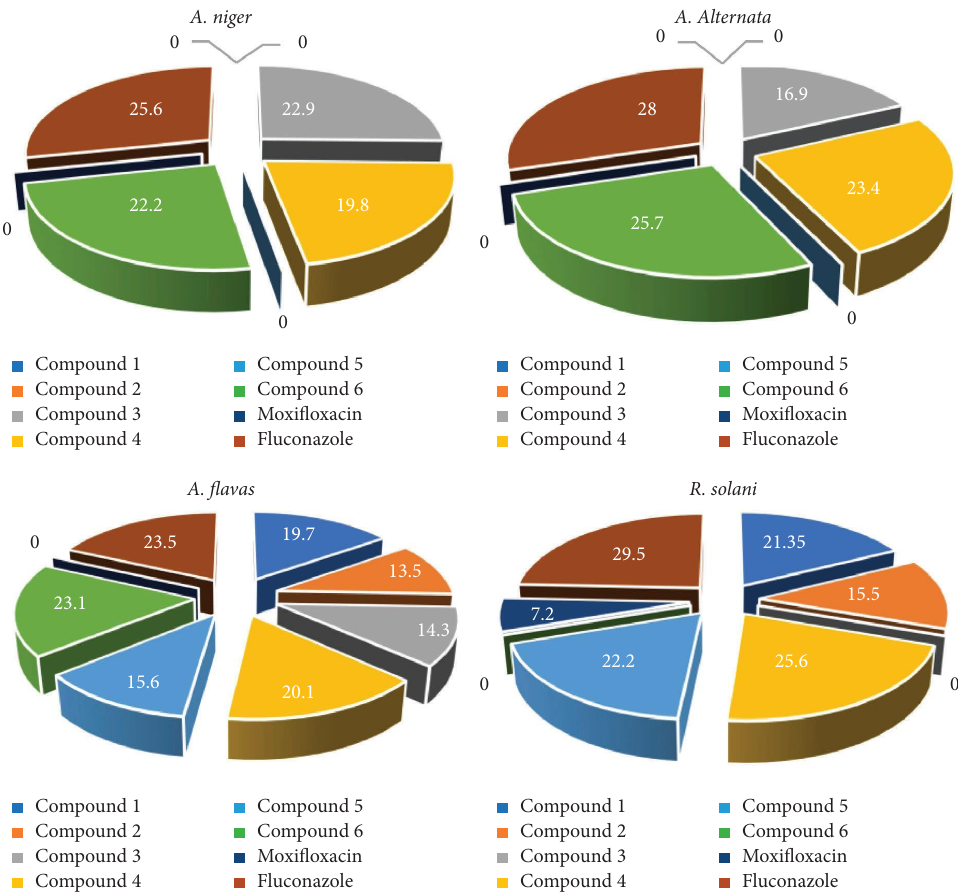
Figure 6: Pie charts representing the extent of antifungal activities of moxifoxacin and its metal complexes.